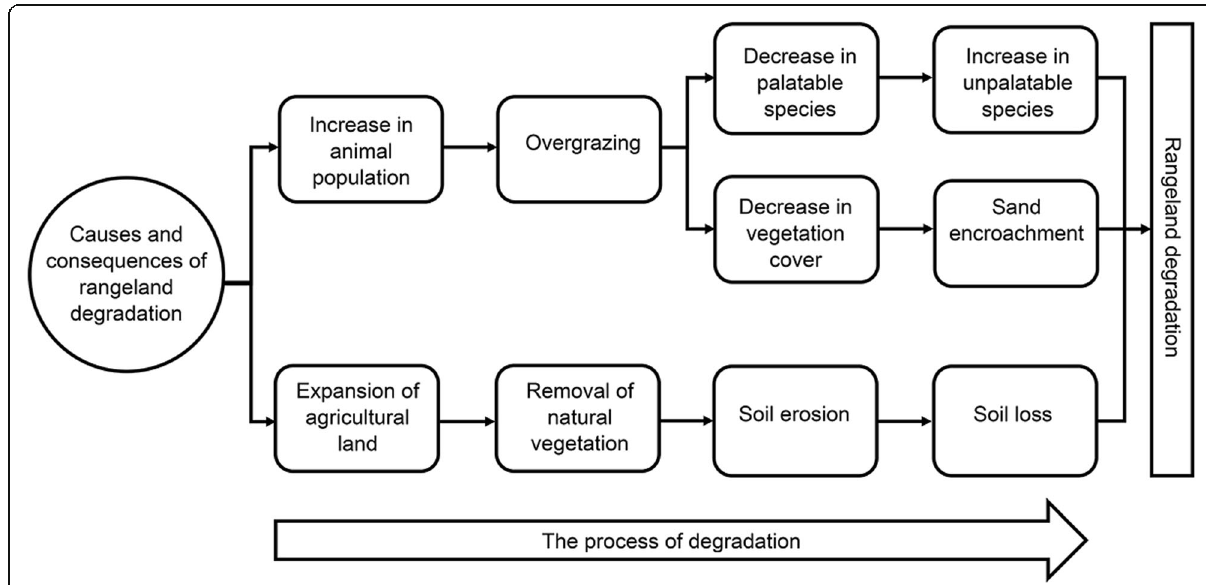
Figure 2 Causal factor chain in Libyan rangeland